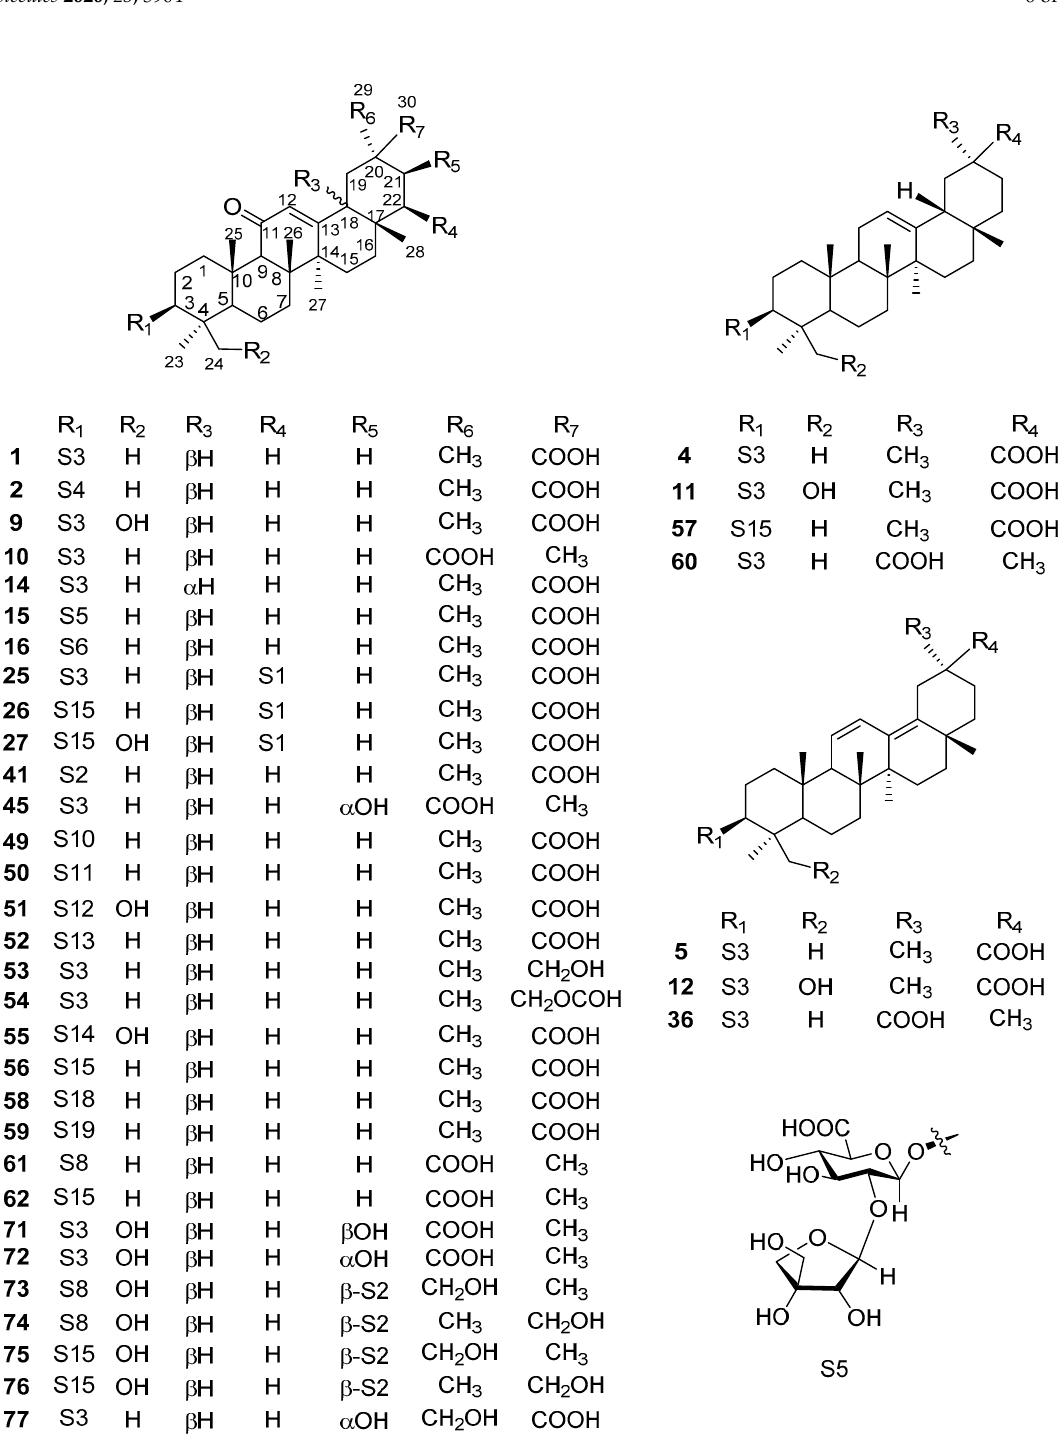
Figure 2. Triterpene saponins in G. glabra.